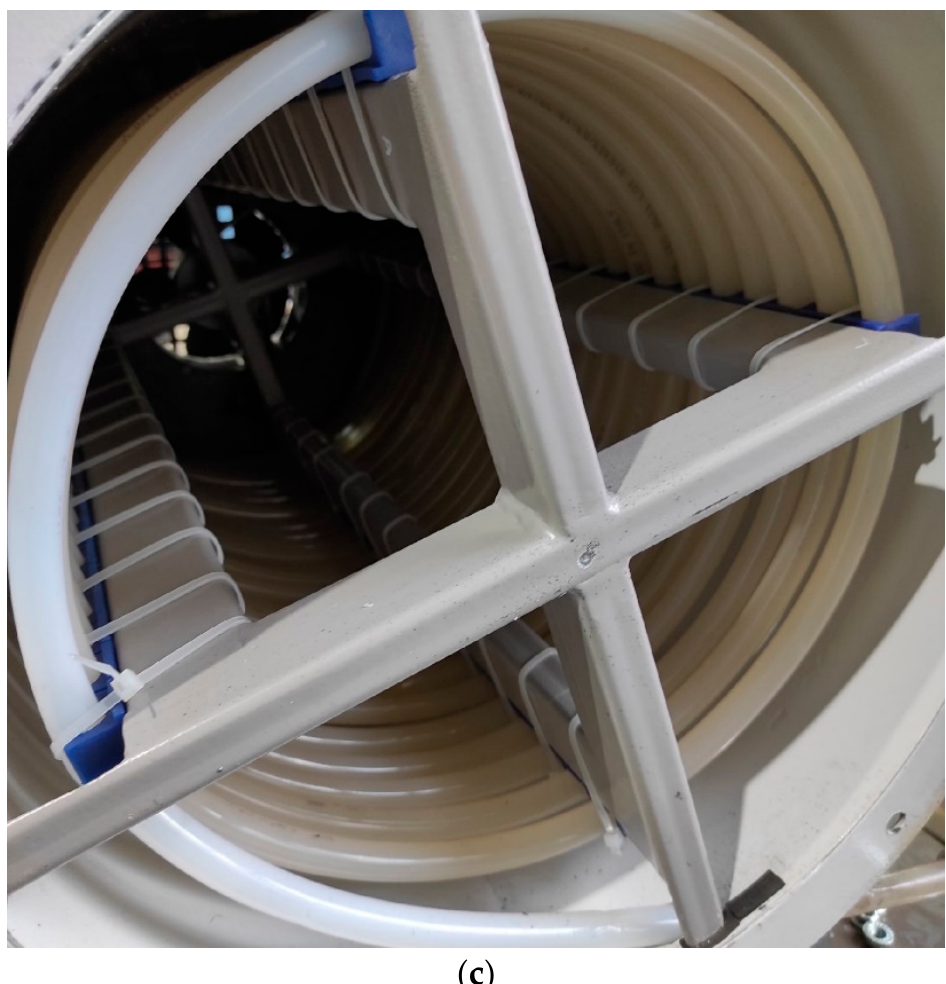
Figure 3. Photo of the laboratory stand; ( a ) laboratory stand (general view); ( b ) photo of the control cabinet; and ( c ) wound coils of the stand.